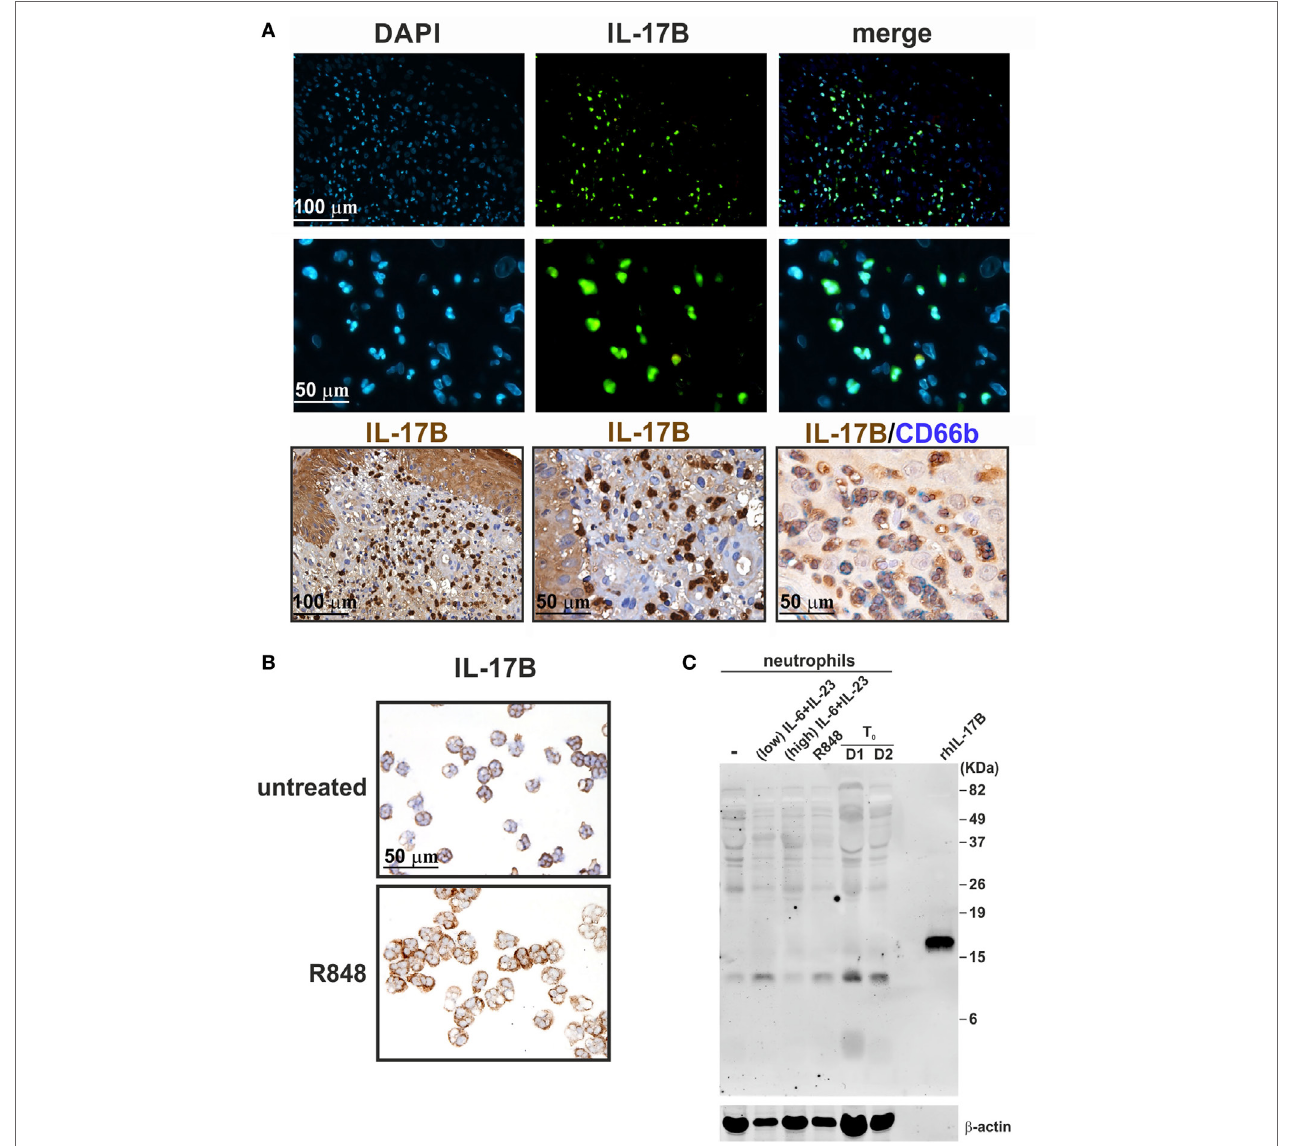
FigUre 10 | Staining human neutrophils by anti-IL-17B (AF1248) antibodies (Abs). (a) Immunofluorescence (top panels) and immunohistochemistry (lower panels) staining of two FFPE cases of human pustular psoriasis using anti-IL-17B (AF1248) and CD66b Abs (as labeled). Top panels show DAPI, FITC channel, and merge to recognize neutrophil shape; lower panels show different magnification of IHC and double IHC to characterize IL-17A + cells with the neutrophil marker CD66b. (B) Cytospins of neutrophils incubated without (top panel) or with 5 µM R848 (bottom panel) for 3 h. Original magnification 200 × [first row in (a) and left image in third row, scale bar 100 µm] and 400 × [second row in (a) , center/right images in third row in (a) , as well as in (B) , scale bar 50 µm]. Images of the second row in (a) represent magnifications of images in first row. (c) AF1248 immunoblot of lysates from neutrophils either freshly isolated (T 0 , from two donors) or incubated for 3 h with or without 2 µg/ml IL-6 plus 0.2 µg/ml IL-23 (low), 20 µg/ml IL-6 plus 2 µg/ml IL-23 (high), or 5 µM R848. Recombinant human IL-17B (rhIL-17B) was used as positive control. Panels (B,c) display representative experiments out of two independent ones with similar